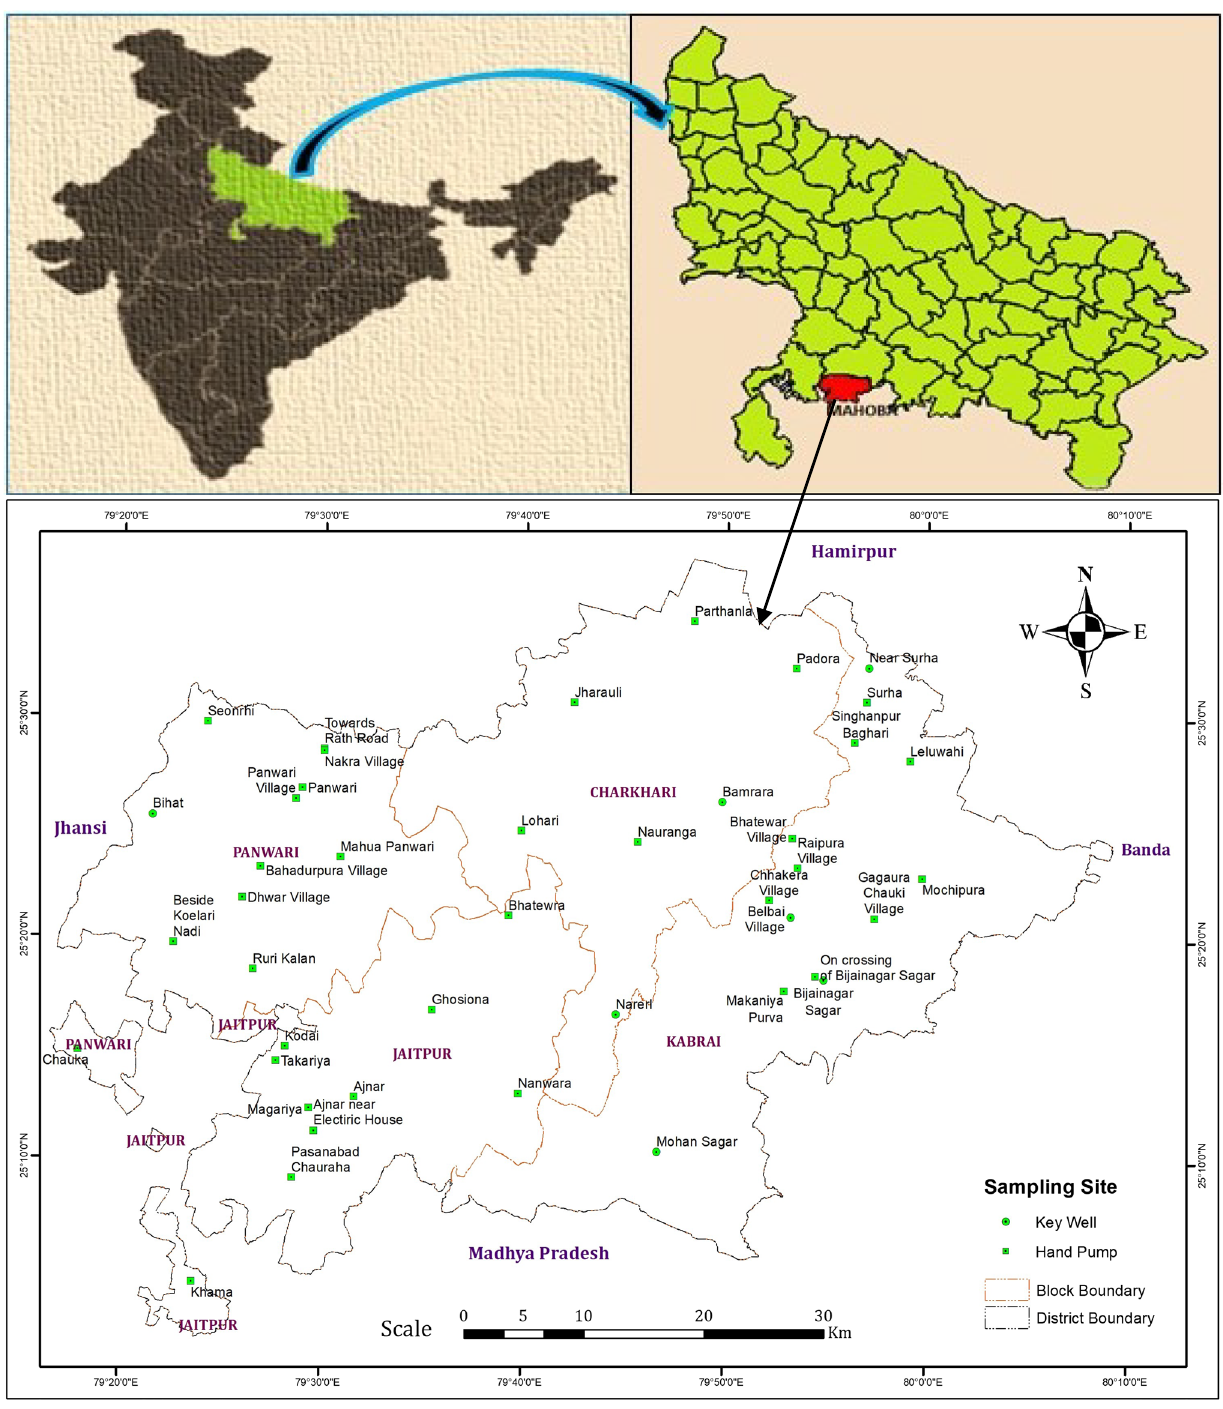
Fig. 1 a Study area map depicting the sampling sites. b Geological map of study